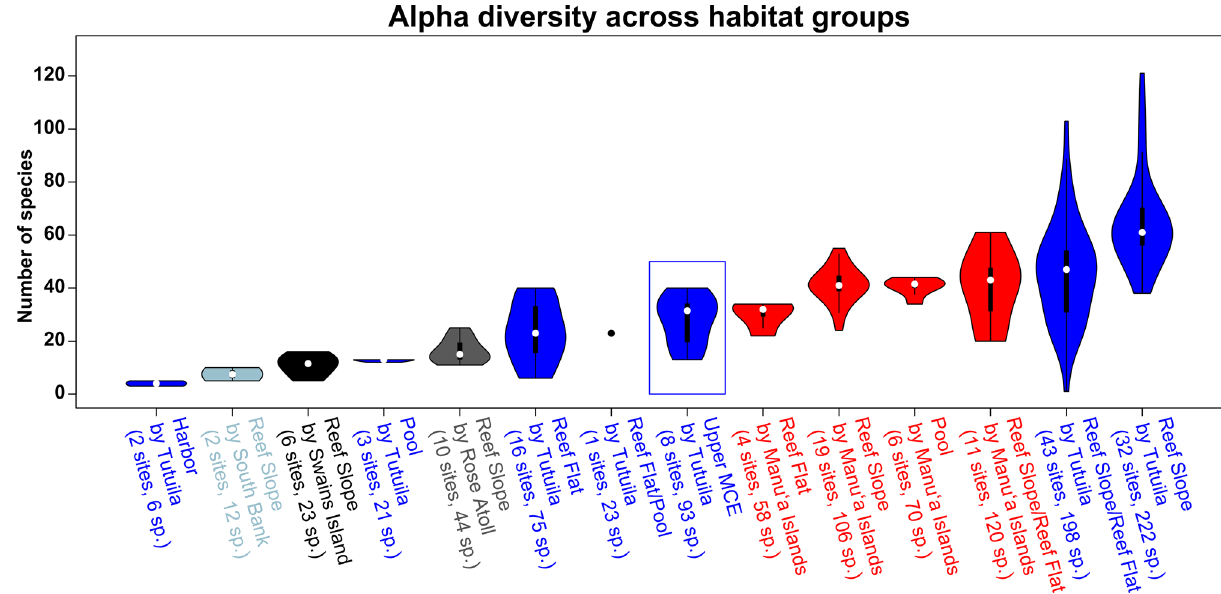
Figure 5. Alpha diversity across various habitats comparing the upper MCE (highlighted by blue box) to 13 other SCR habitat groups. Islands are represented by the same color and are the same for Fig.